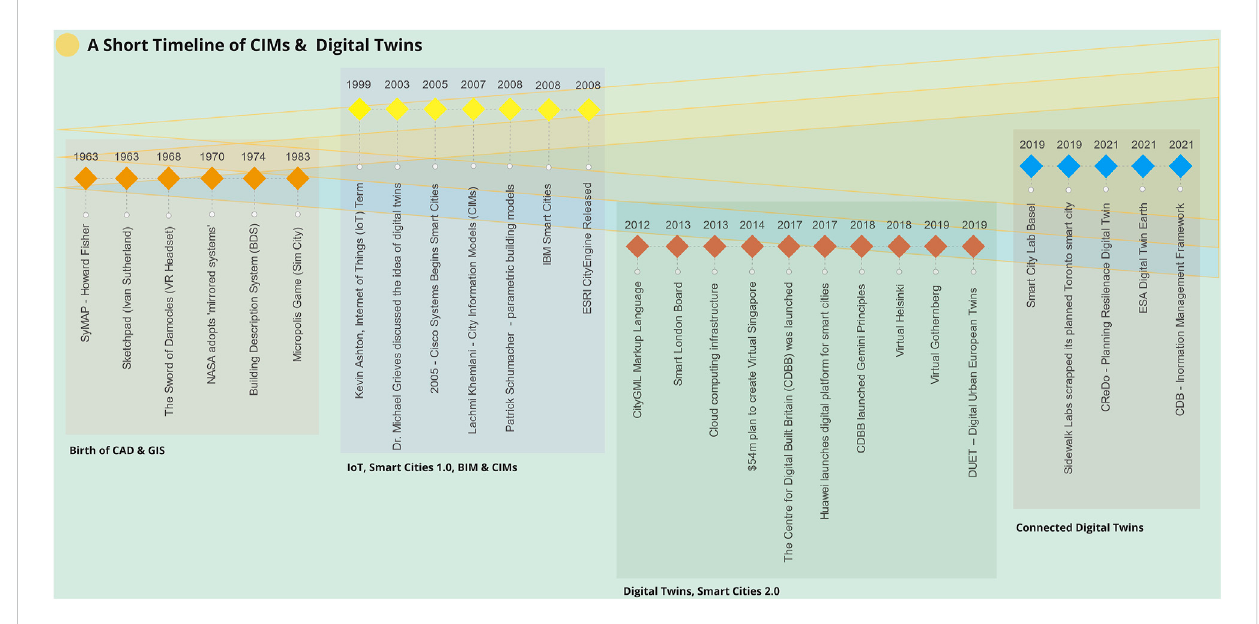
FIGURE 1 A visual timeline of the emergence of City and or Urban Digital